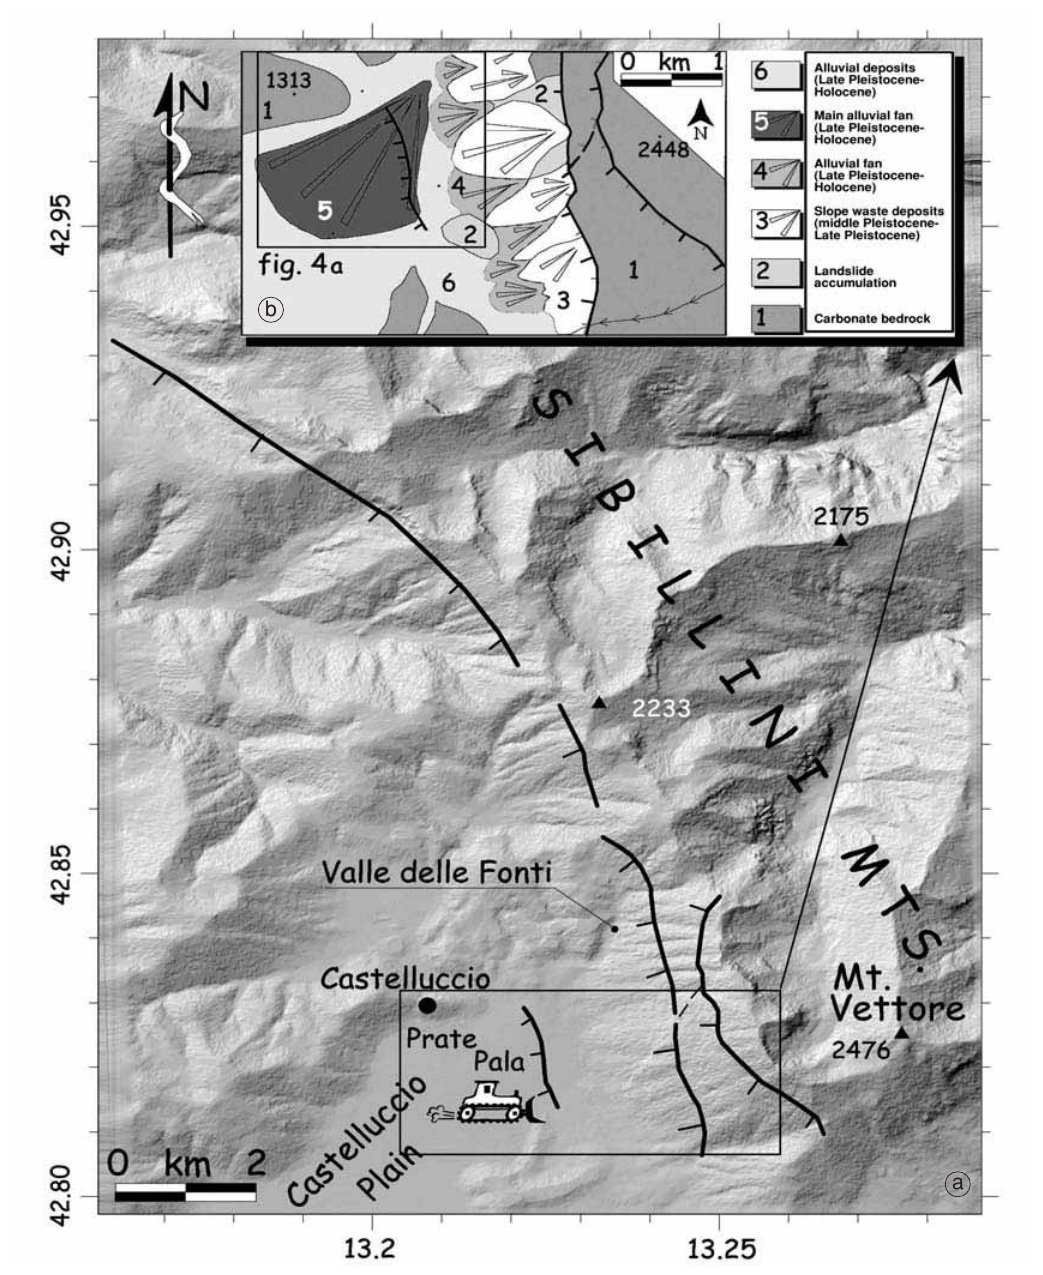
Fig. 3a,b. a) Map of the Mt. Vettore fault area; the trenches were excavated across the minor segment located in the Prate Pala area. b) Geomorphological map of the Castelluccio Plain: the Prate Pala scarp affects the large Late Pleistocene-Holocene alluvial fan fed from the Valle delle Fonti